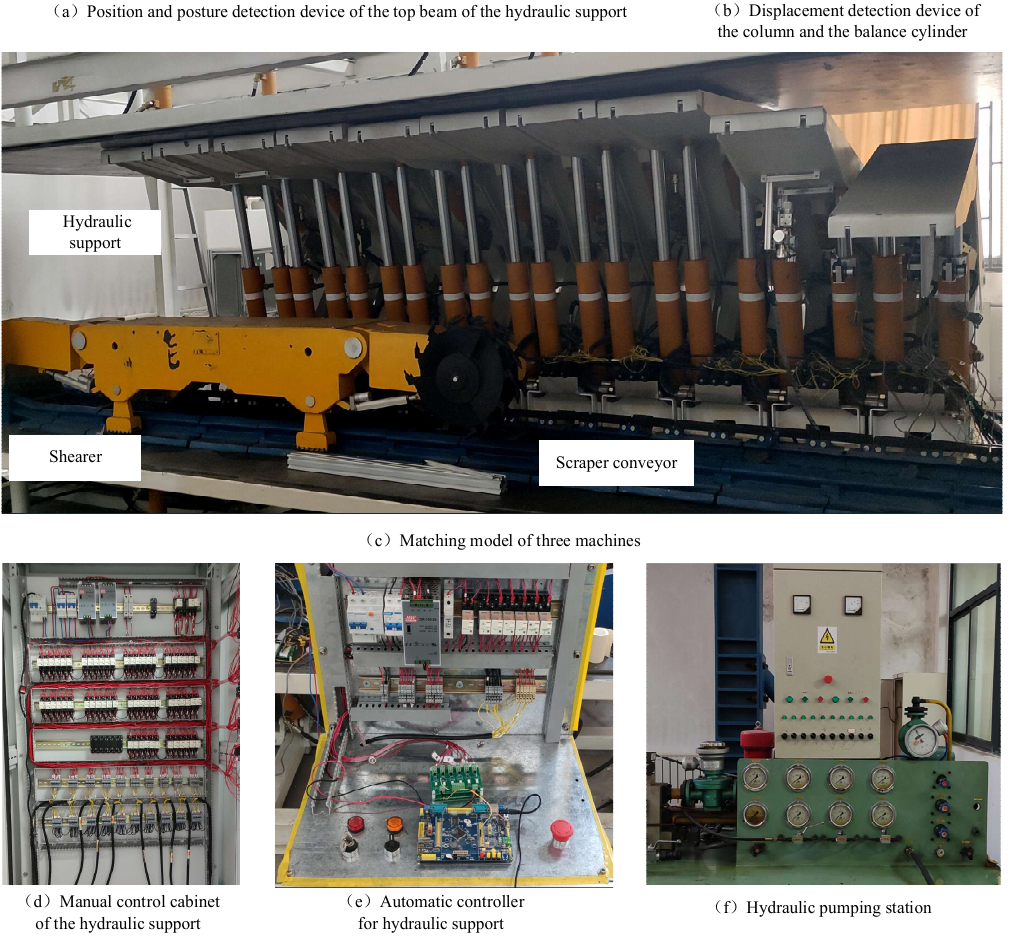
Figure 8. Hydraulic support relative position and posture detection experimental platform.